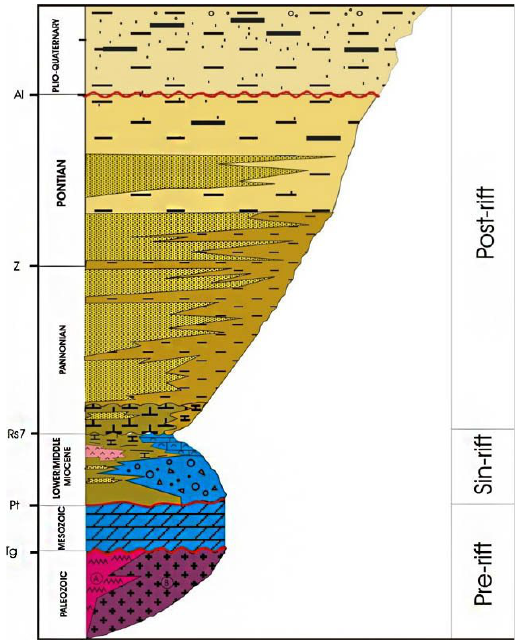
Figure 2. Schematic geological column of the Pannonian basin [53,61].